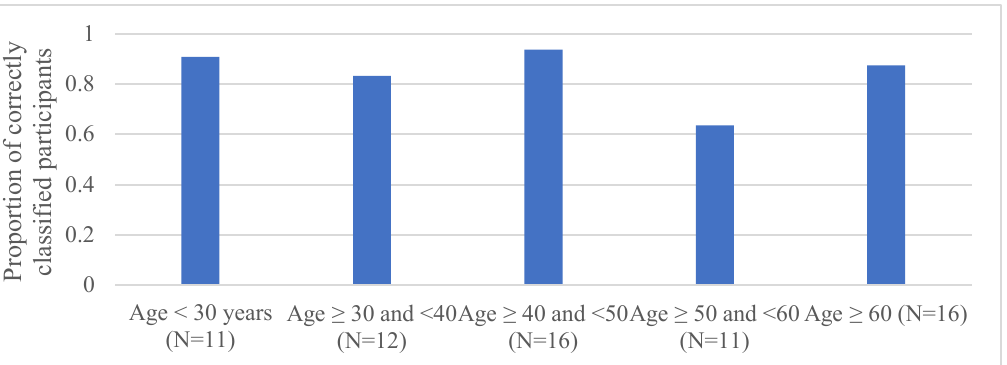
Figure 2. Proportion of participants classified correctly by the SMARTED scale per age group. We set the cut-off value at three (i.e., scores of three and above indicate a cluster headache).